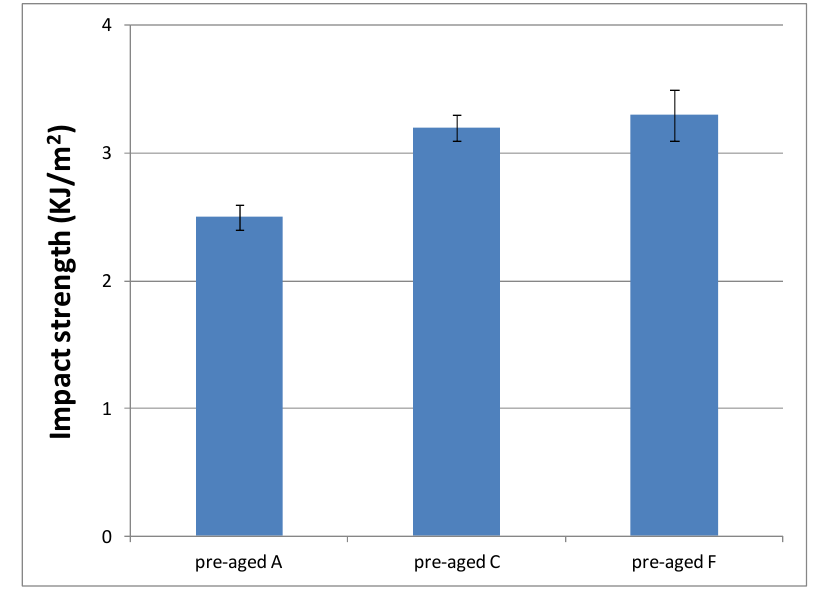
Figure 13. Impact strength values of materials prepared from A, C and F formulations.